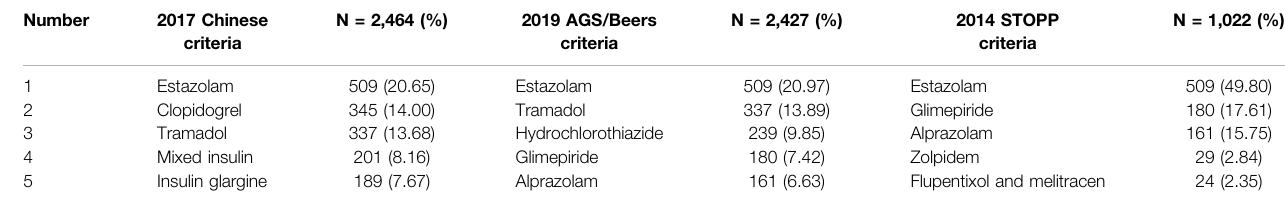
TABLE 4 | The fi ve most consumed PIMs used by older cancer outpatients. Number 2017 Chinese